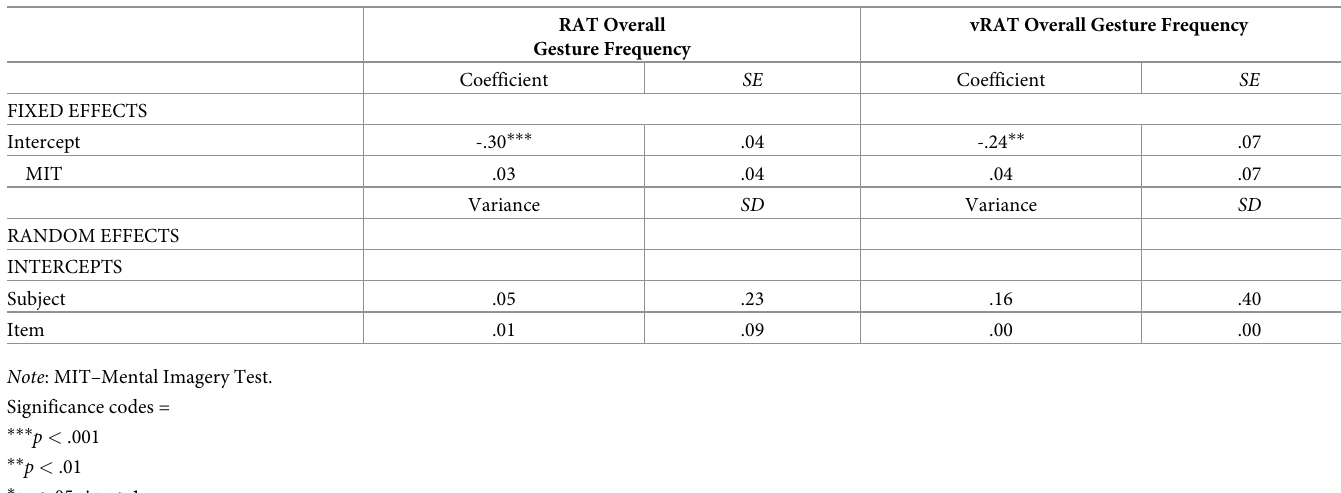
Table 6. Summary of models for Hypothesis